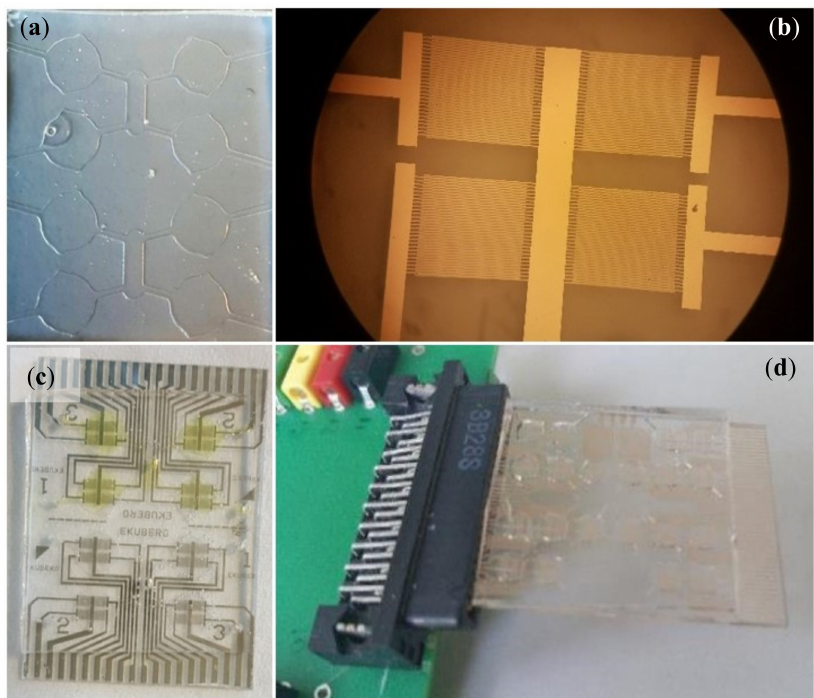
Figure 2. ( a ) Microfluidic modules for fluid handling consisting of four chambers per sides connected by a network of microchannels; ( b ) detail of the four interdigited electrodes available in each sensing area; ( c , d ) image of the lab-on-chip and its connection to the interface printed circuit board.